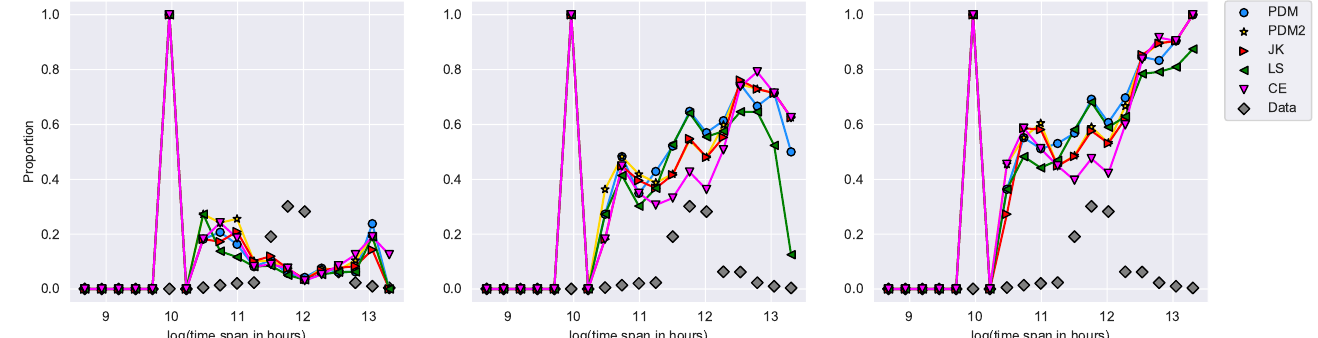
Figure 7. The comparison of different period finding algorithms considering the different time spans for the step size defined in Equation (3) with A = 10. The criterion for comparison is the proportion of asteroids having a successful periodic recovery. From left to right, the three plots are for different δφ max = 85/50,850/50 and 8500/50. The gray diamonds indicate the proportion of asteroids at the corresponding time span in our data